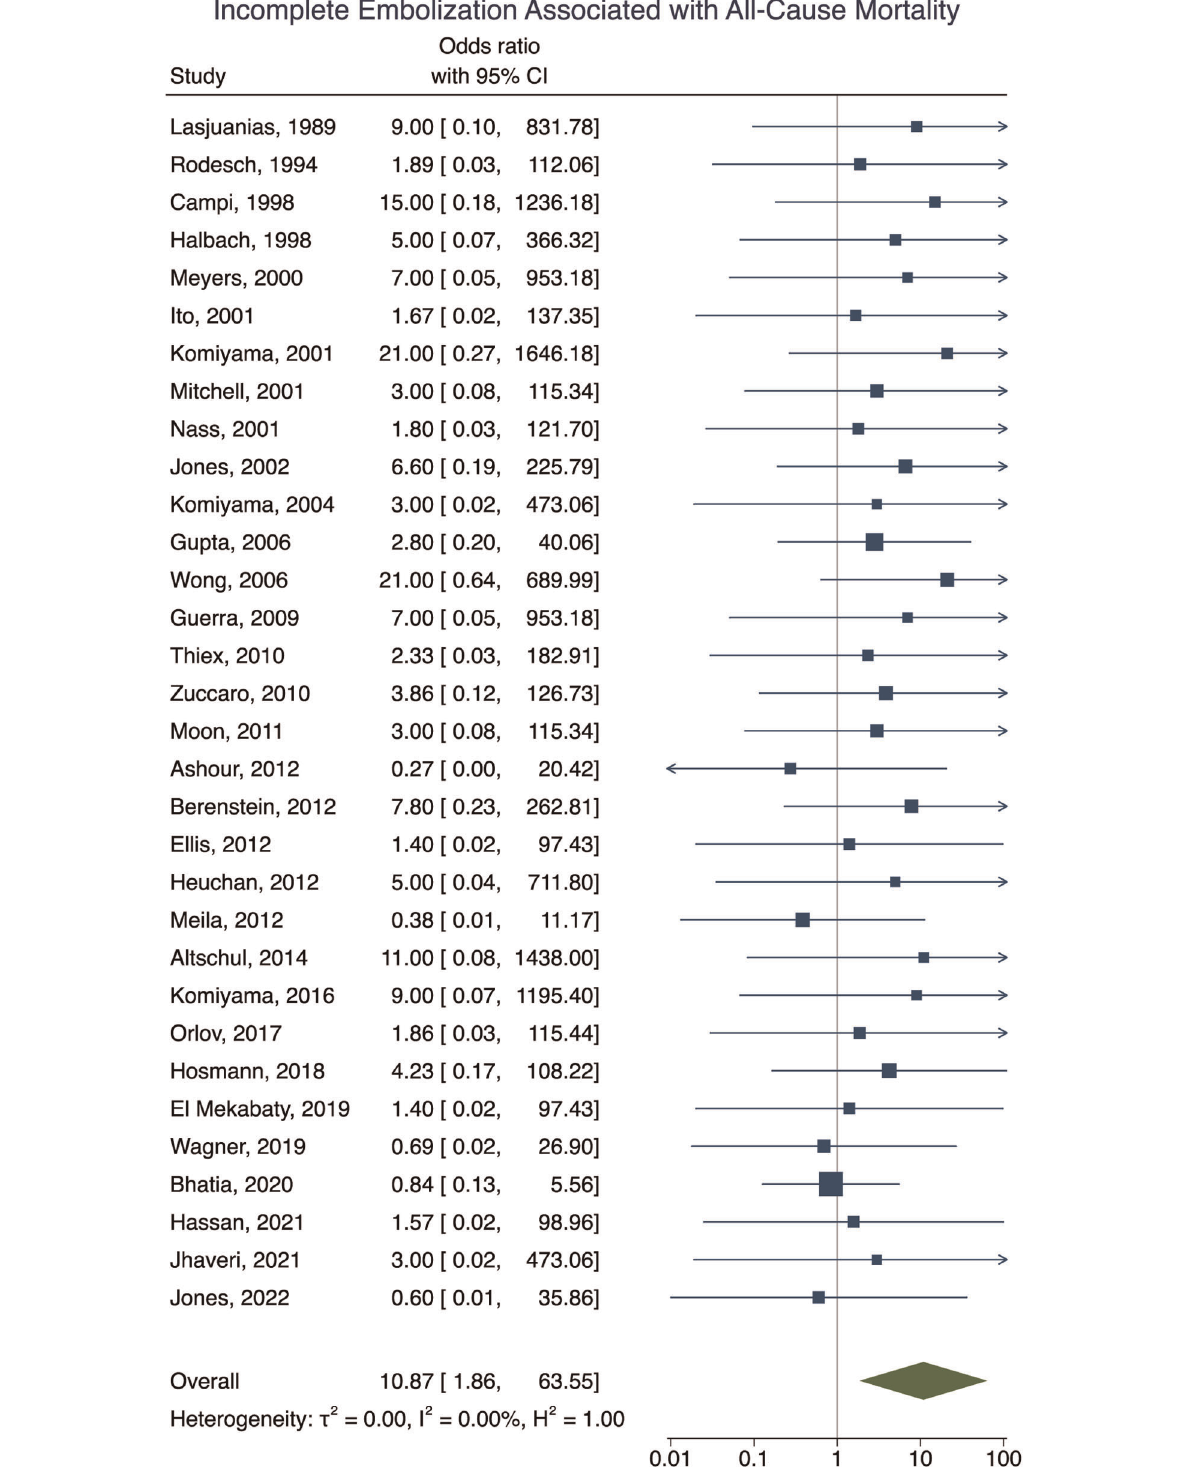
FIGURE 6 Forest plot showing the association of incomplete embolization with all-cause mortality after VOGM embolization.